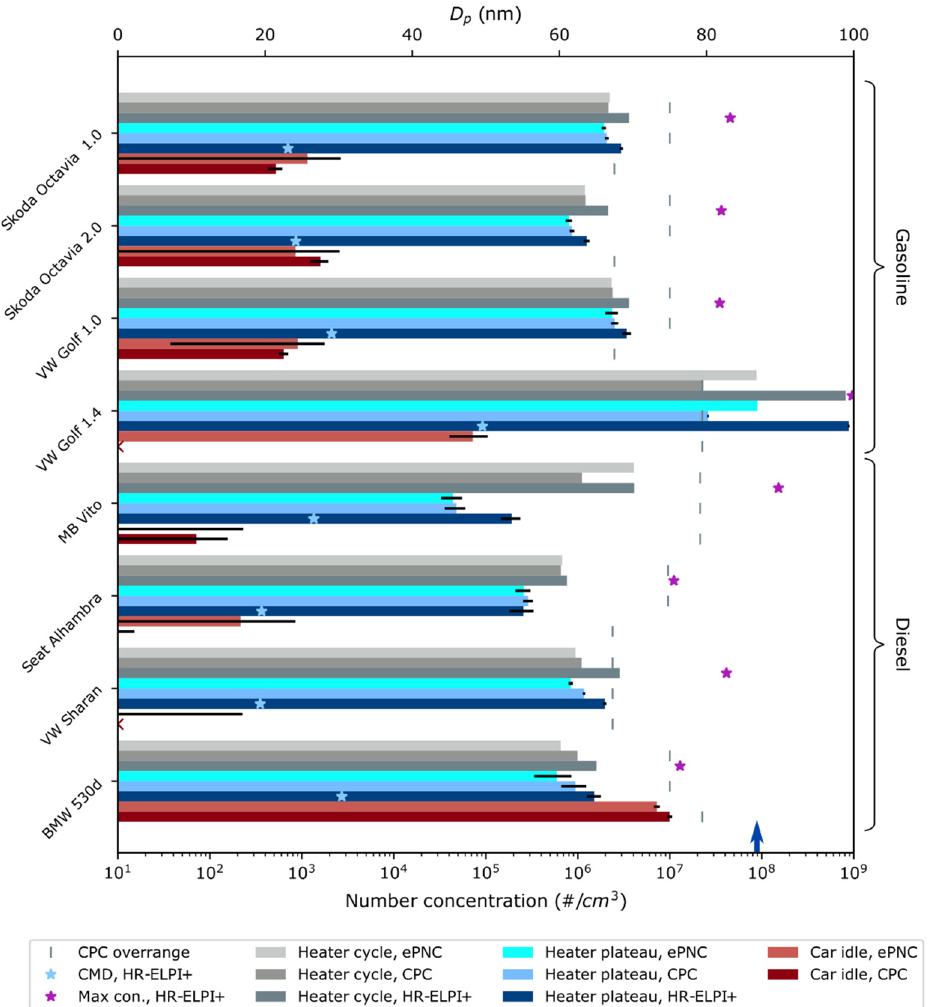
Figure 3. Average particle number concentrations measured from the vehicle exhaust during engine idling and from the auxiliary heater exhaust during its operation. Averages are calculated from both the plateau period as well as from the full range of operation (20 min cycle including the startup and shutdown of the heater). Count median diameters of the particle size distributions measured with the HR-ELPI+ and the CPC overrange limits are presented as well. CPC data were not available for two car idle measurements, these are indicated in the figure with a red “X”. ePNC overrange limit is indicated with a dark blue arrow.